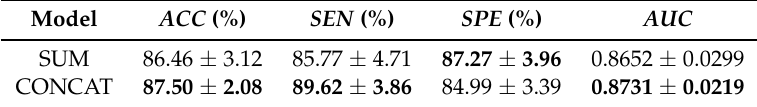
Table 10. Classification performance of different combination methods for T1